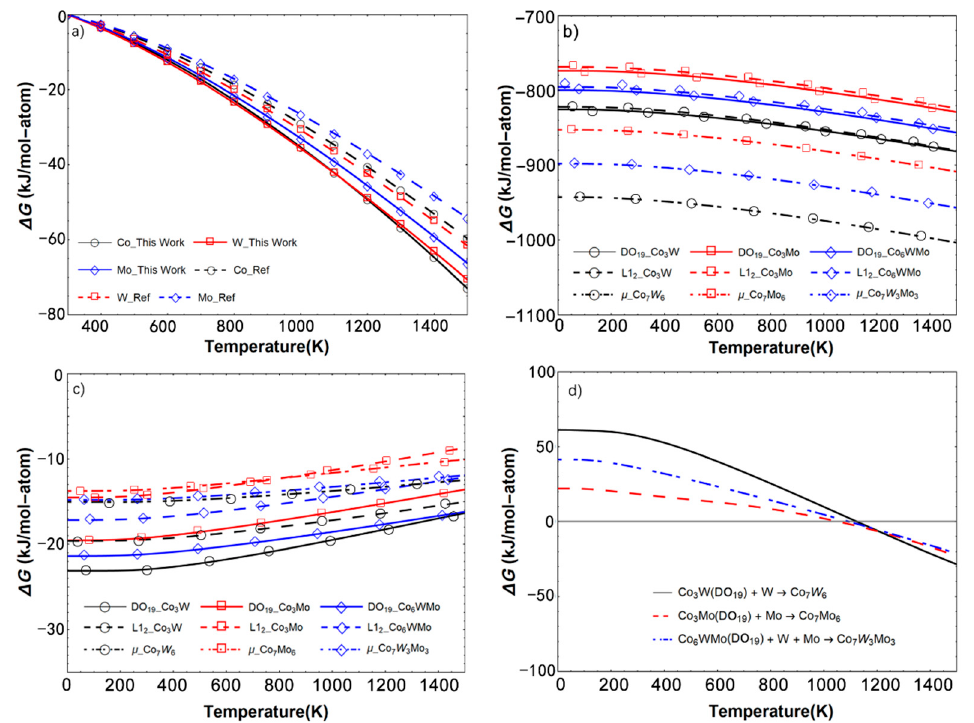
Figure 5. ( a ) The calculated and recommended Δ G of Co, W and Mo (the values at 300 K represent the benchmark); ( b ) the calculated mean values of the Co–W/Mo compounds in the DO 19 , L1 2 and μ structures; ( c ) formation Gibbs free energy of the Co–W/Mo compounds in the DO 19 , L1 2 and μ structures; and ( d ) Δ G of the phase transformation from Co 3 X to Co 7 X 6 .